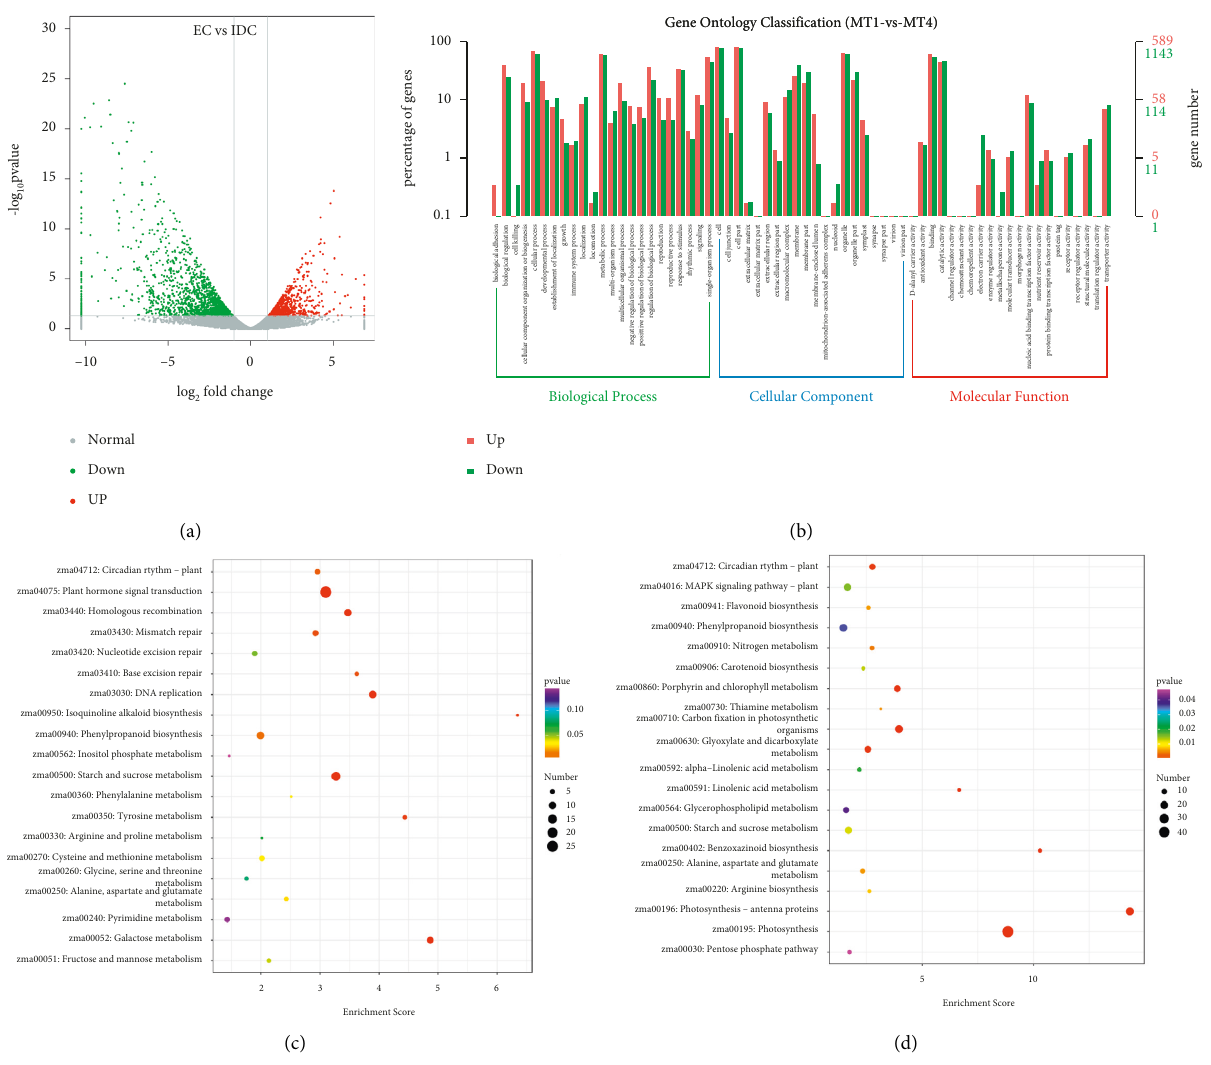
Figure 6: Statistics of functional analysis of DEGs between EC and IRC. (a) The volcano plot presenting the expression of the DEGs between EC and IRC. (b) Histogram of GO for significant clustering of DEGs in three processes. (c) KEGG analysis of upregulated gene between EC and IRC. (d) KEGG analysis of downregulated gene between EC and